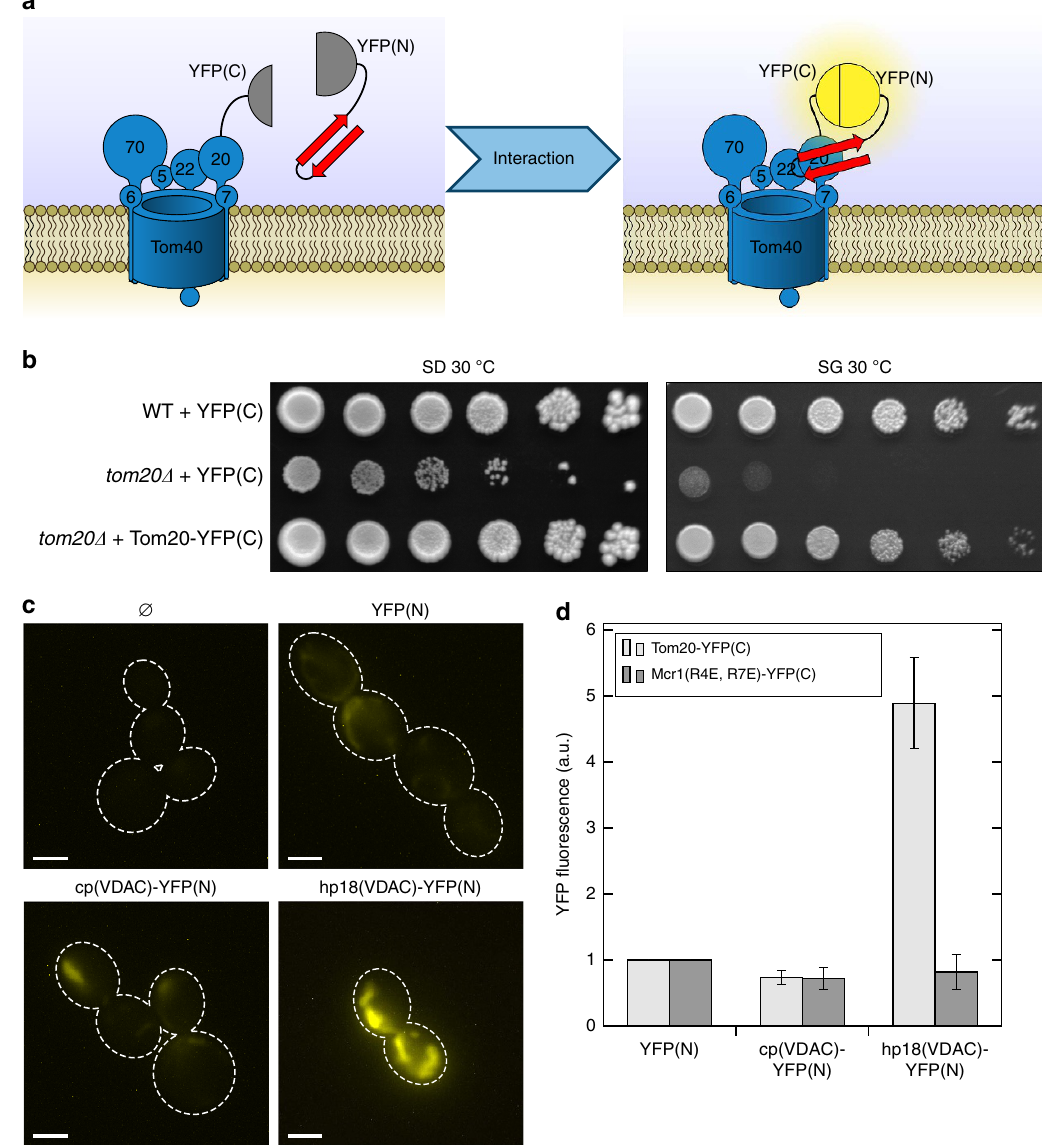
Figure 8 | A b -hairpin peptide interacts with the import receptor Tom20 in vivo . ( a ) Schematic representation of the assay. Tom20 was fused with the C-terminal part of YFP (YFP(C)) whereas the N-terminal part of YFP (YFP(N)) was fused to the b -hairpin peptide (red). YFP fluorescence can be observed only upon interaction of the two fusion proteins. ( b ) The growth of WT and tom20 D yeast cells expressing either YFP(C) or the fusion protein Tom20- YFP(C) was analyzed by drop-dilution assay. ( c ) Yeast cells expressing Tom20-YFP(C) alone (Ø), or co-expressing Tom20-YFP(C) with YFP(N), the control peptide (cp(VDAC)) fused to YFP(N) or hp18(VDAC) fused to YFP(N) were subjected to fluorescence microscopy. Representative images are shown. Scale bar, 5 m m. ( d ) Crude mitochondria were isolated from cells co-expressing the indicated YFP(N) fusion proteins and either Tom20-YFP(C) or Mcr1(R4E, R7E)-YFP(C). The YFP fluorescence of the crude mitochondrial fractions was analyzed and the signal of cells expressing YFP(N) without any additive was set to 1. Data represents mean ± s.d. of three independent